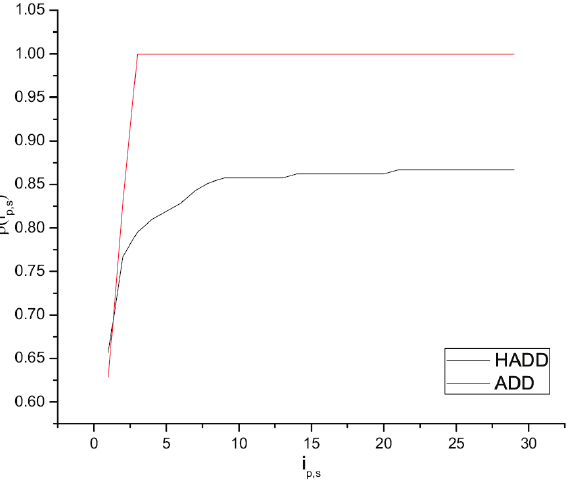
Figure 4. Performance profiles for the HADD and ADD methods regarding the number of itera- tions metric.